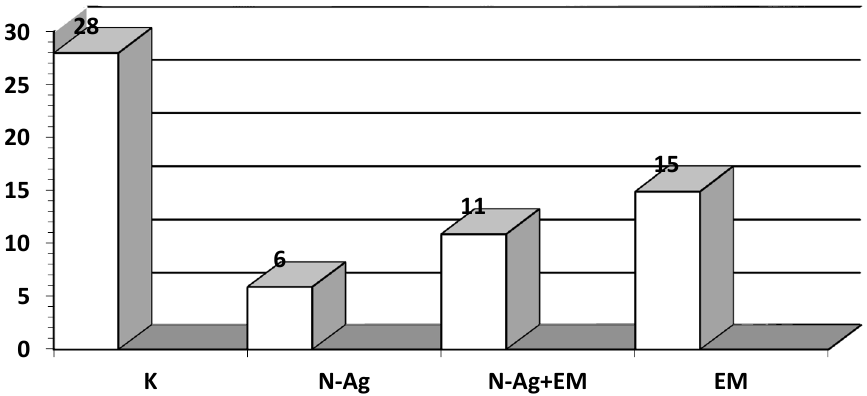
Figure 2. Estimated percentage (%) mortality of Cornu aspersum (Müller) snails for the fattening period on the experimental plots. EM: effective microorganisms.